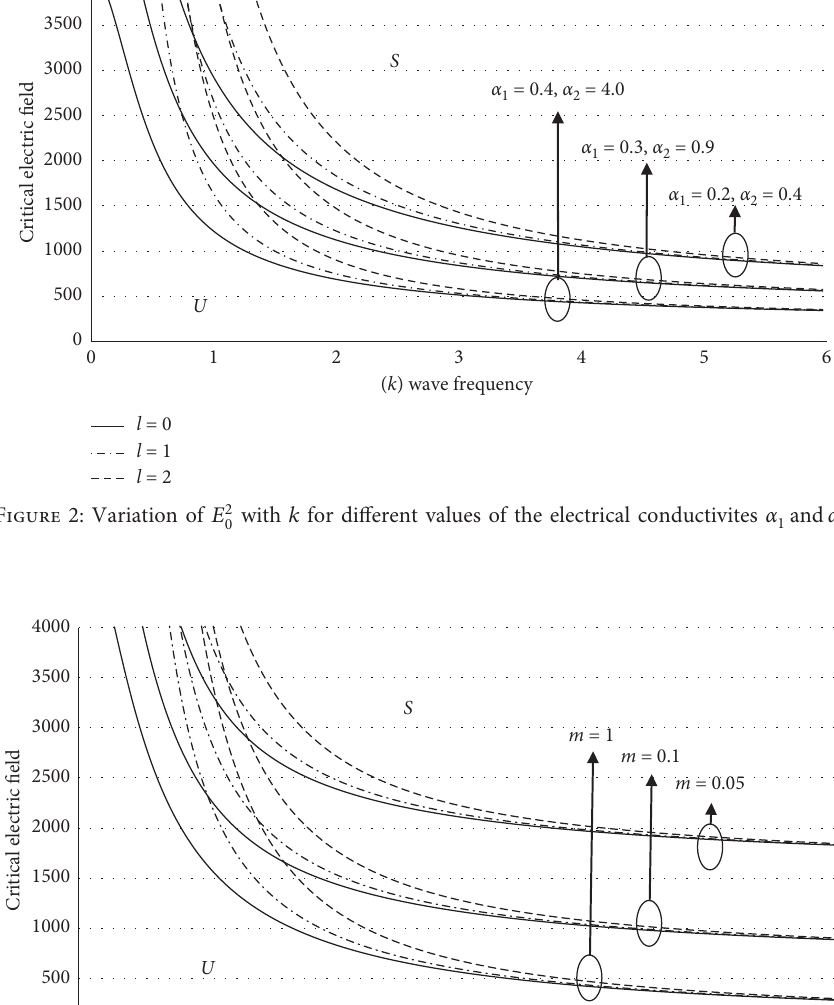
Figure 3: Variation of E 2 with k for different values of the porosity of a porous medium m . 0